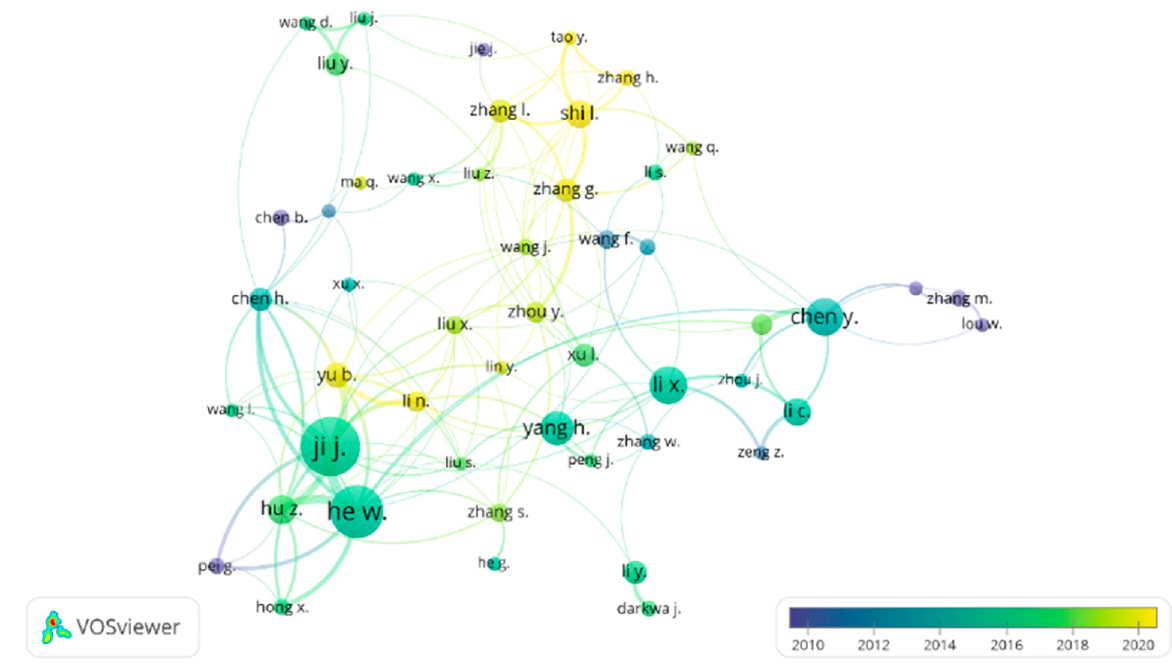
Figure 22. Bibliometric analysis of authors. Countries in which researchers are actively developing the topic of climate-adaptive façades can be seen in Figure 23. China, the United States of America, the United Kingdom, Italy, and Australia are leaders among others in this topic.